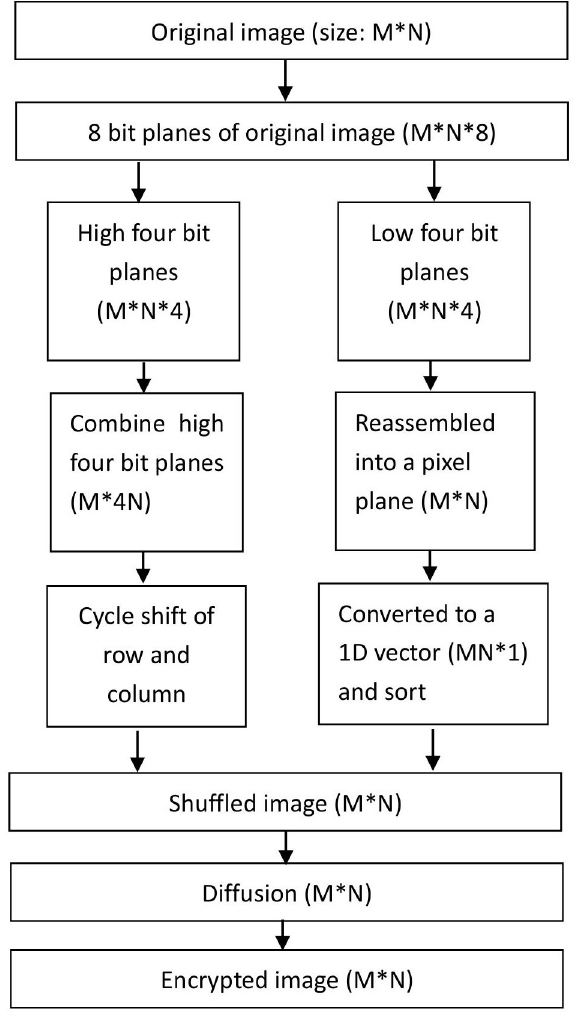
Figure 5. Process of JPB image